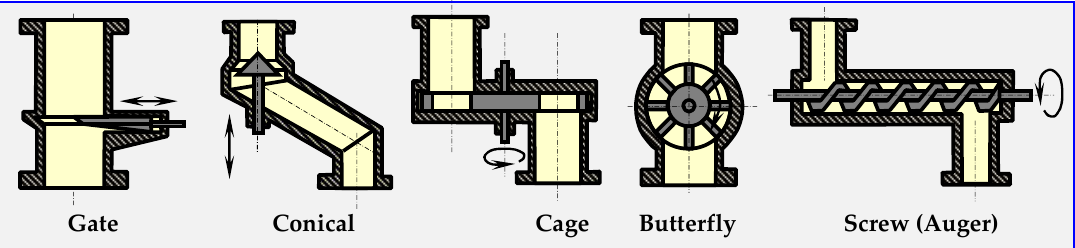
Gate Cage Butterfly Screw (Auger) Conical Figure 20. Types of sluices or valves for dosing loose materials [17]. Figure 20. Types of sluices or valves for dosing loose materials